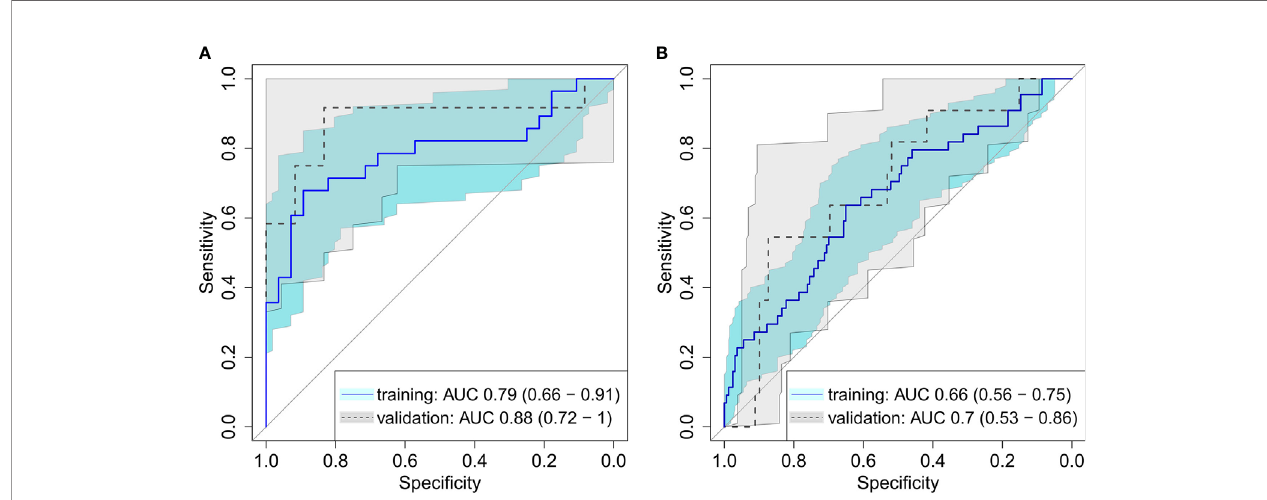
FIGURE 2 | Receiver operating characteristic for (A) differentiation between recurrent and controlled sub-volumes in bi-regional radiomics model showing a good discrimination between the radioresistance levels, in both the training and the validation cohort (B) detection of recurrent sub-volumes with local radiomics showing a good performance of the model with ability to detect radioresistant sub-volumes of the tumor on pretreatment CT